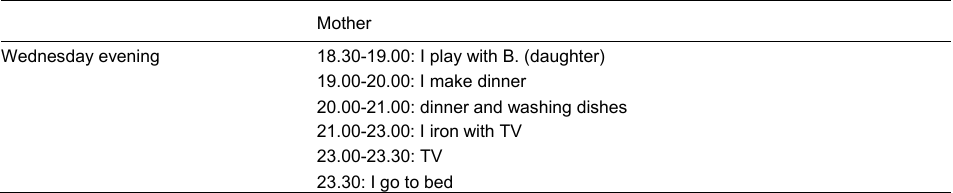
Table 1 : Self-reported charts of Giti mother during the evening of a